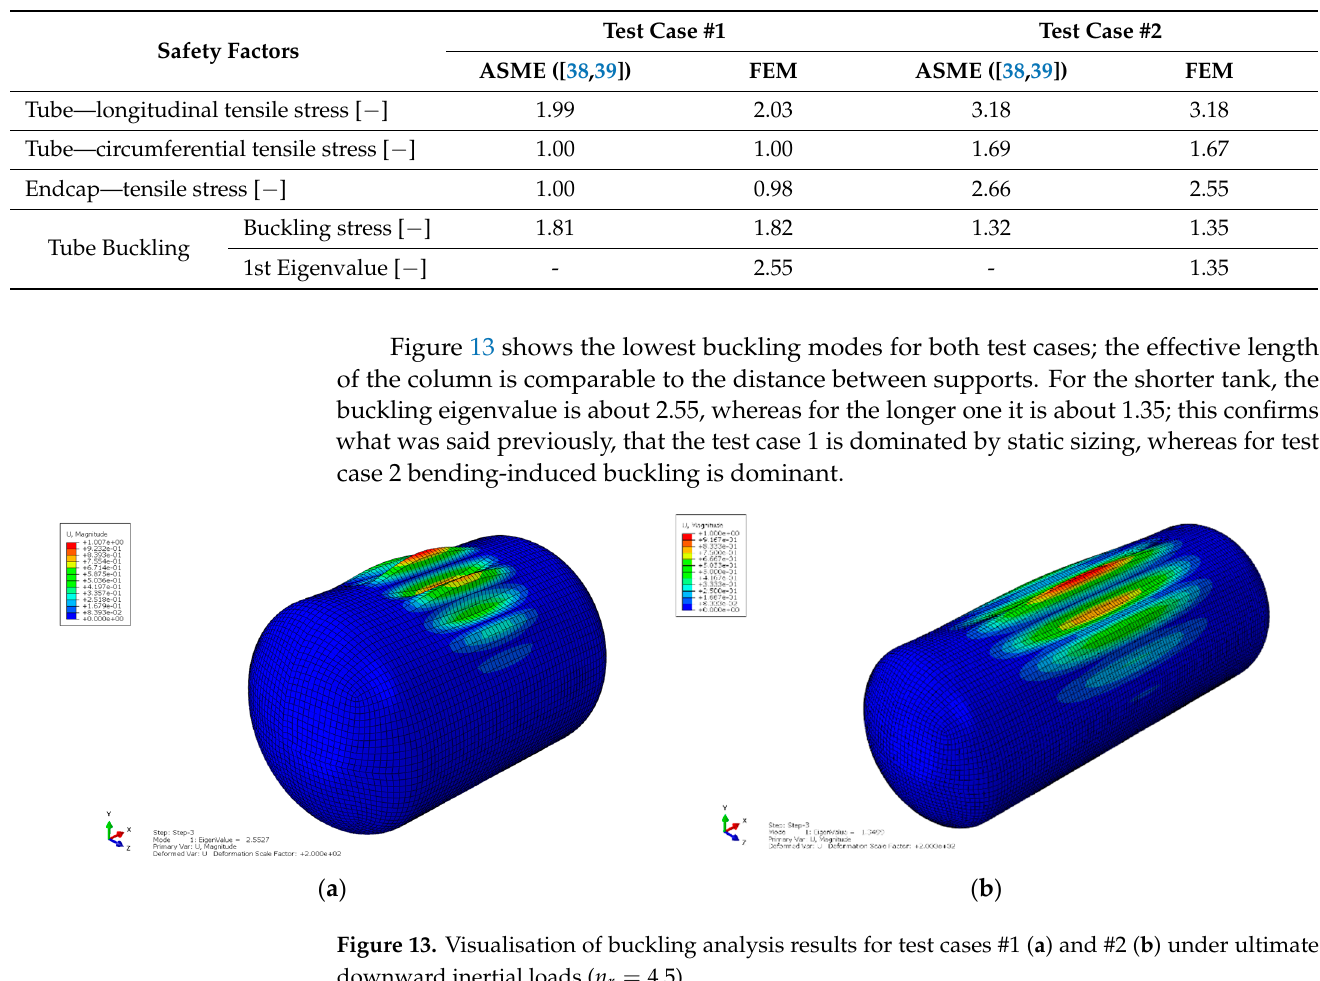
Table 6. Safety factors calculated for the structural test cases.